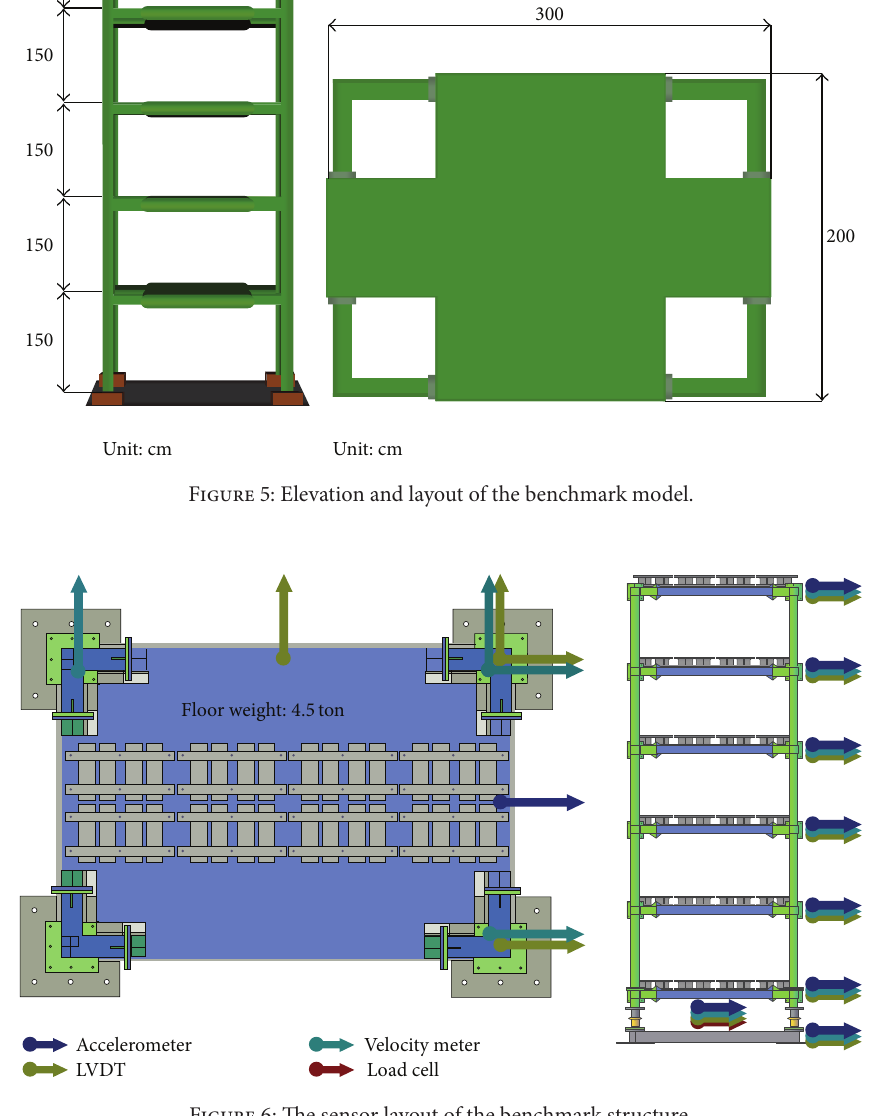
Figure 6: The sensor layout of the benchmark